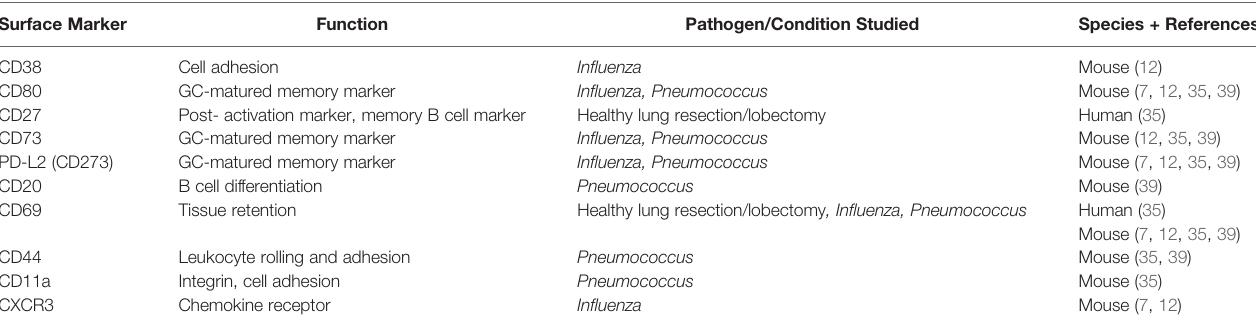
TABLE 2 | Surface Marker Expression of Human/Mouse Pulmonary B RM